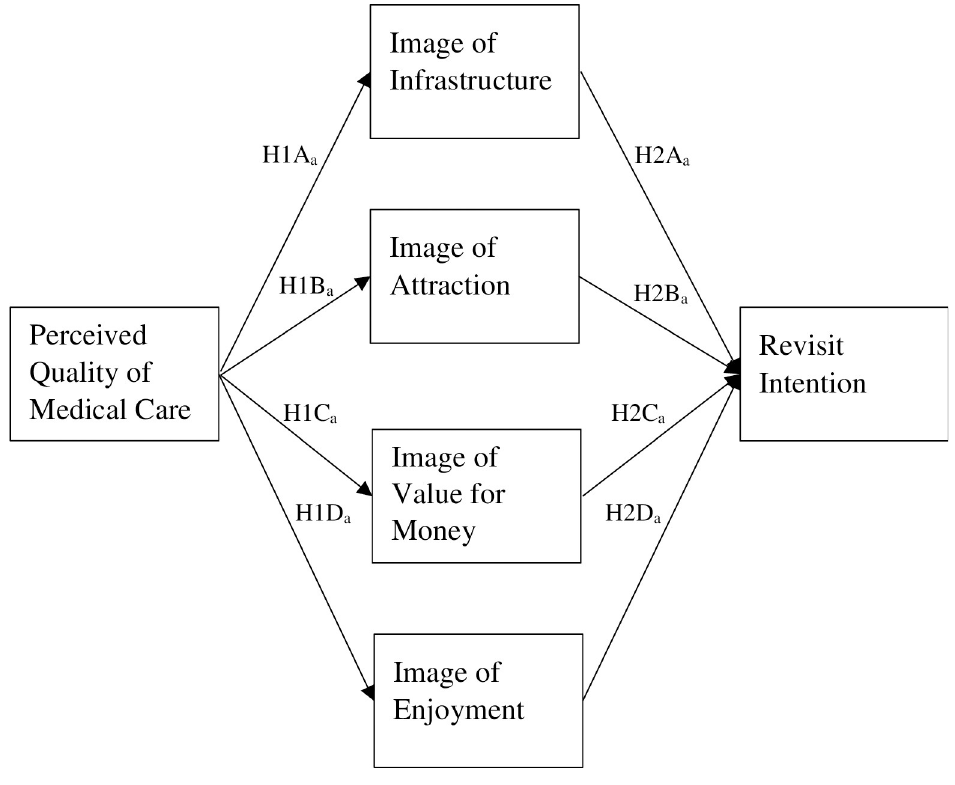
Fig 1. Conceptual